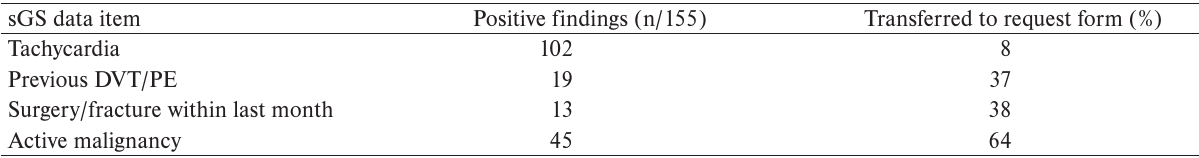
Table 2. Data items of sGS considered positive using the CIS and RIS and their availability in RIS.